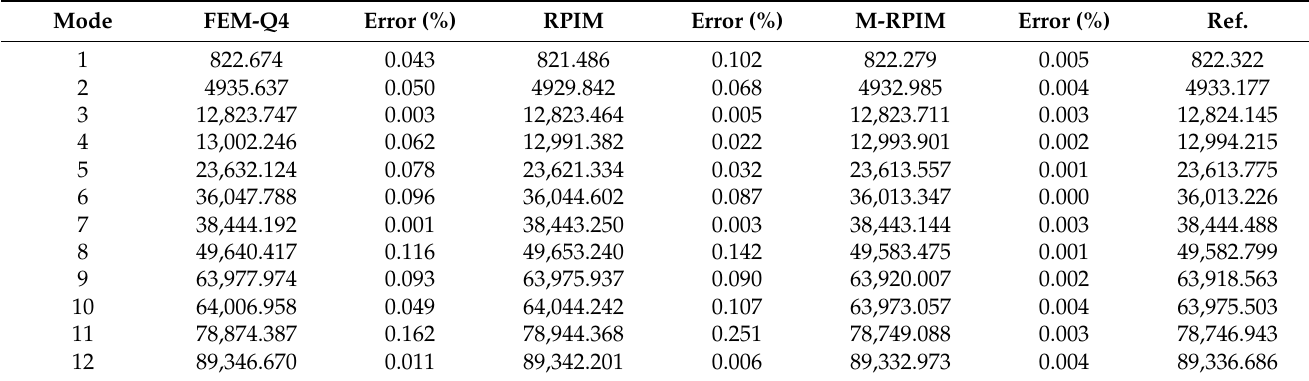
Table 4. The first twelve natural frequency solutions from the three numerical methods using the node arrangement pattern with average nodal space h = 0.5